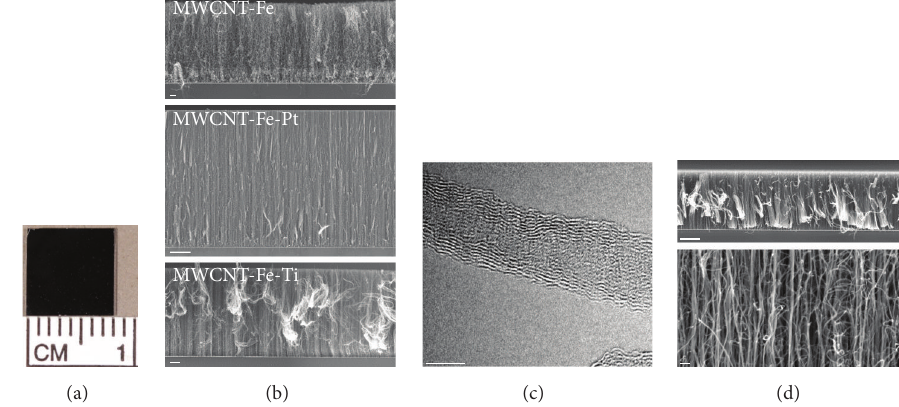
Figure 1: Characterization of vertically aligned MWCNT growth achieved by a nanoscale catalyst layer of Fe, Fe-Pt, and Fe-Ti. (a) Synthesis was carried out on 8 × 8 mm 2 silicon wafer pieces by chemical vapor deposition. (b) Scanning electron microscopy demonstrated the aligned growth of the synthesized MWCNT with a length of 18 𝜇 m for the Fe catalyst (scale bar: 1 𝜇 m), 60 𝜇 m for the Fe-Pt catalyst (scale bar: 10 𝜇 m), and 85 𝜇 m for the Fe-Ti catalyst (scale bar: 10 𝜇 m). (c) High-resolution transmission electron microscopy demonstrated the integrity and consistency of the Fe-Ti catalyzed MWCNT growth with an outer diameter of 9nm and an inner diameter of 3nm (scale bar: 5 nm). (d) Steam sterilization at 121 ∘ C for 30 minutes showed no impairment (scale bar upper panel: 10 𝜇 m, scale bar lower panel: 100